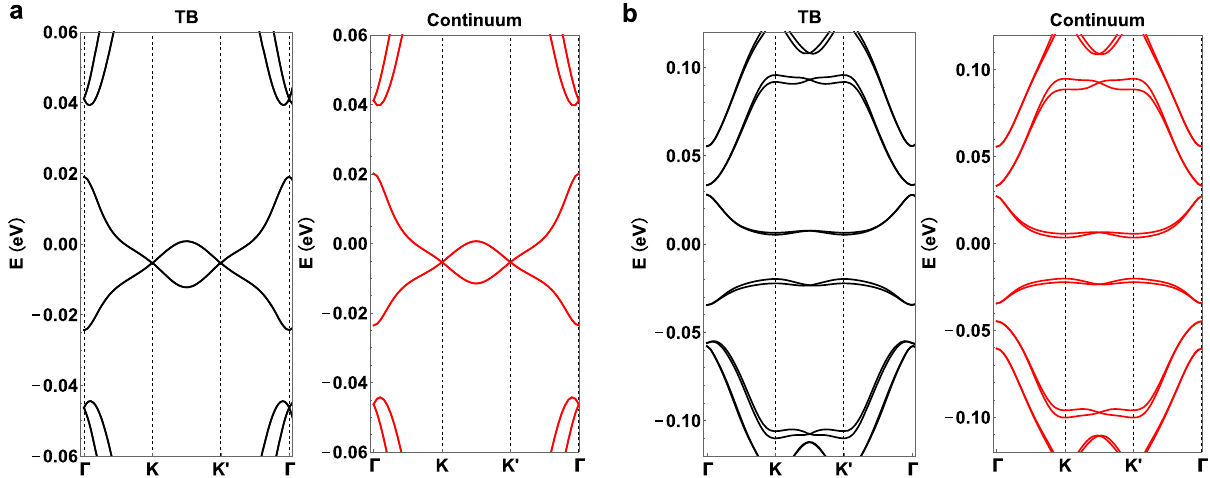
that represents a spatially uniform mass term 45 . Notice that the potentials induced by the substrate, Eq. (5), preserve time-reversal symmetry. This allows us to describe its effect in a single-valley model. Surprisingly, having identi fi ed that some of the potential pro fi les in the TB solutions indicate the existence of additional harmonics (see Supplementary Note 7), we fi nd that the modulation of V SL at smaller wavelengths has some effects on the narrow bands and, therefore, Eq. (6) has to be expanded up to two harmonics. As described in Ref. 24,29 , the minimal model for an hBN substrate depends on eight parameters: uniform on-site term ω Δ , position-dependent scalar terms V e and 0 , constant mass gap s V o